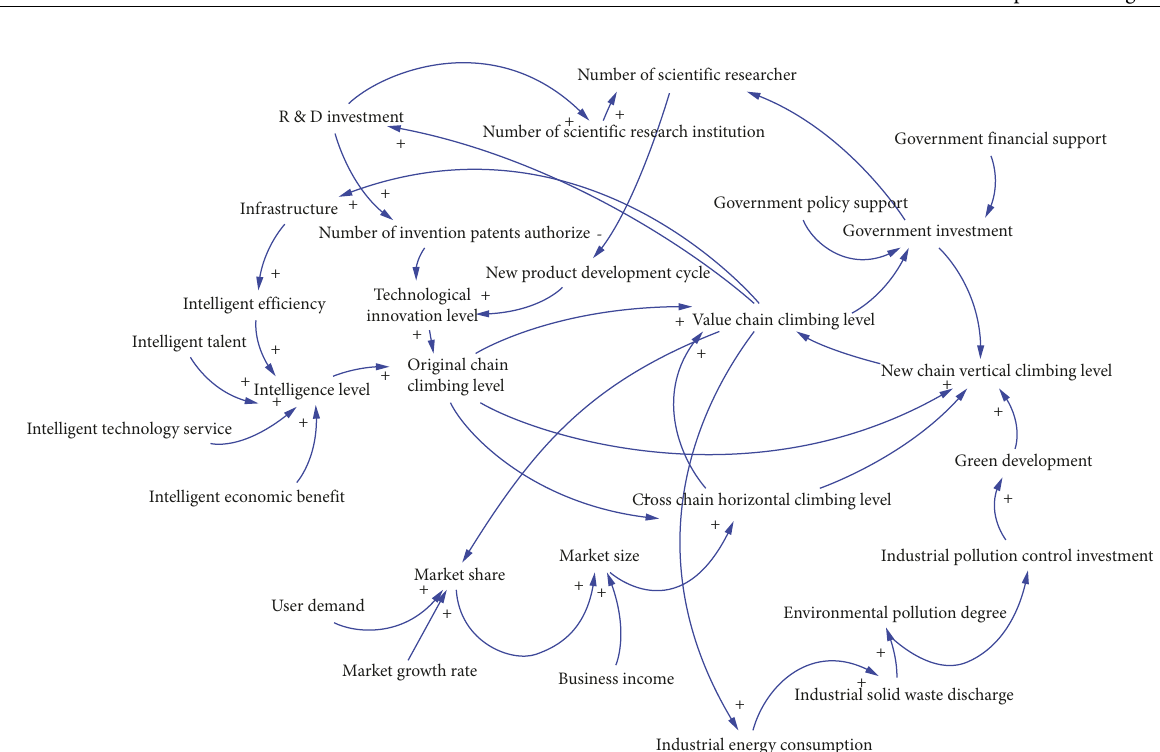
Figure 2: Cause and effect diagram of the value chain climbing system under intelligent transformation.